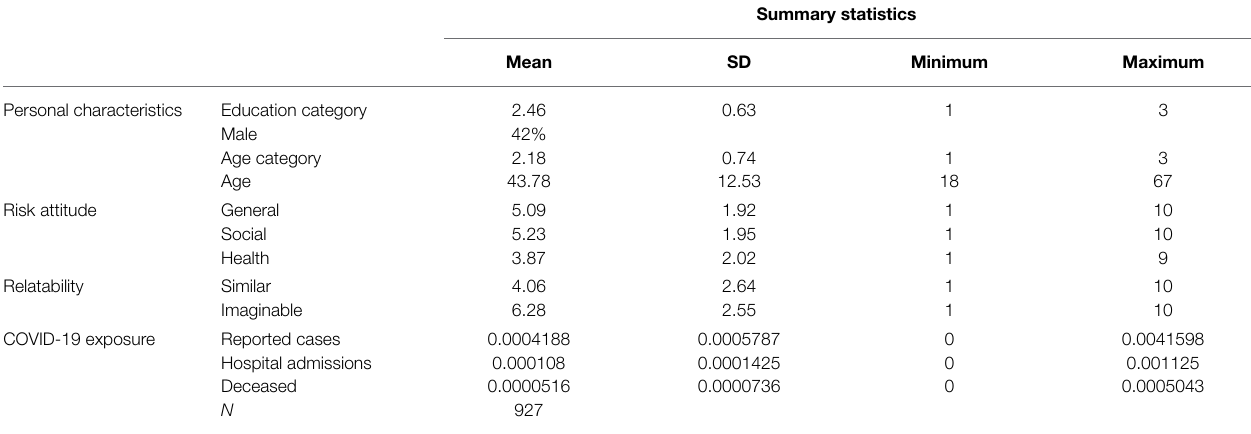
TABLE 1 | Summary statistics.